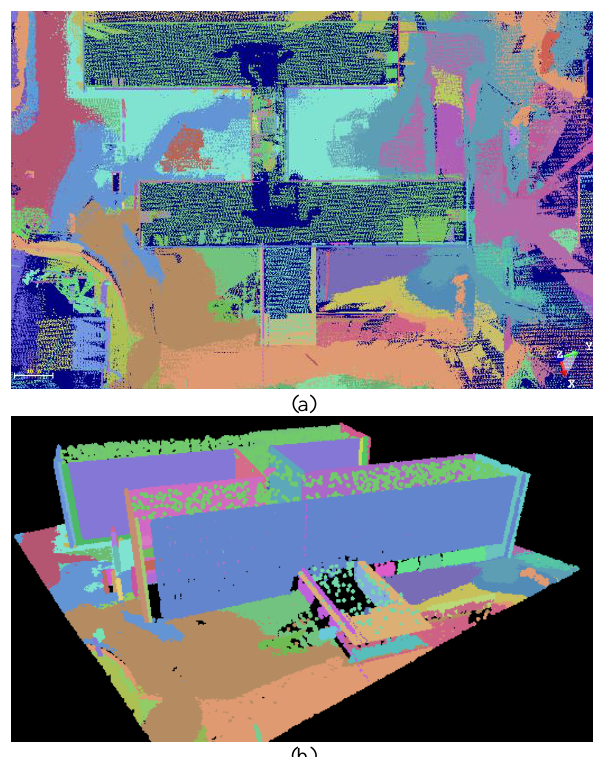
Figure 8: A top view of the Yamnuska Hall segmented point cloud (a) and an isometric view of the same structure.